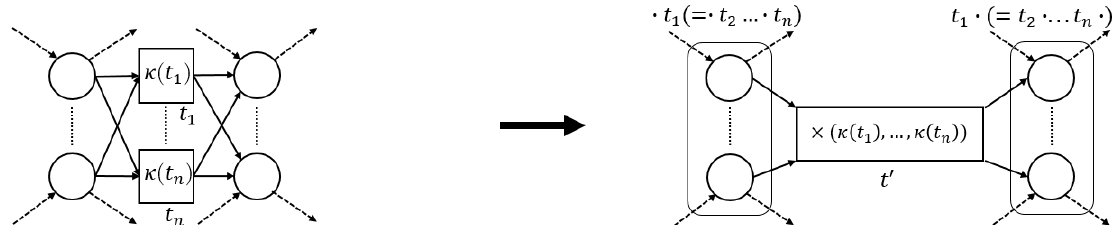
Figure 10. Visualization of the × -pattern reduction (dashed arcs are allowed to be part of the pattern, while solid arcs are required). All transitions in the pattern share the same pre- and post-set. The replacing transition inherits the aforesaid pre- and